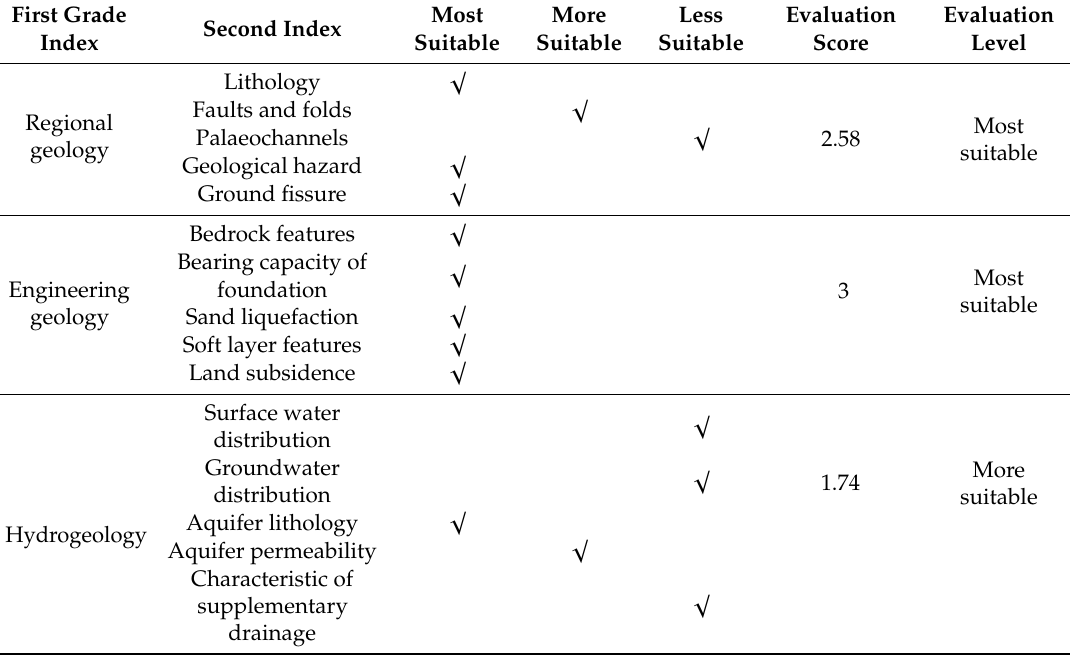
Table 9. Suitability assignment and classification table for underground space